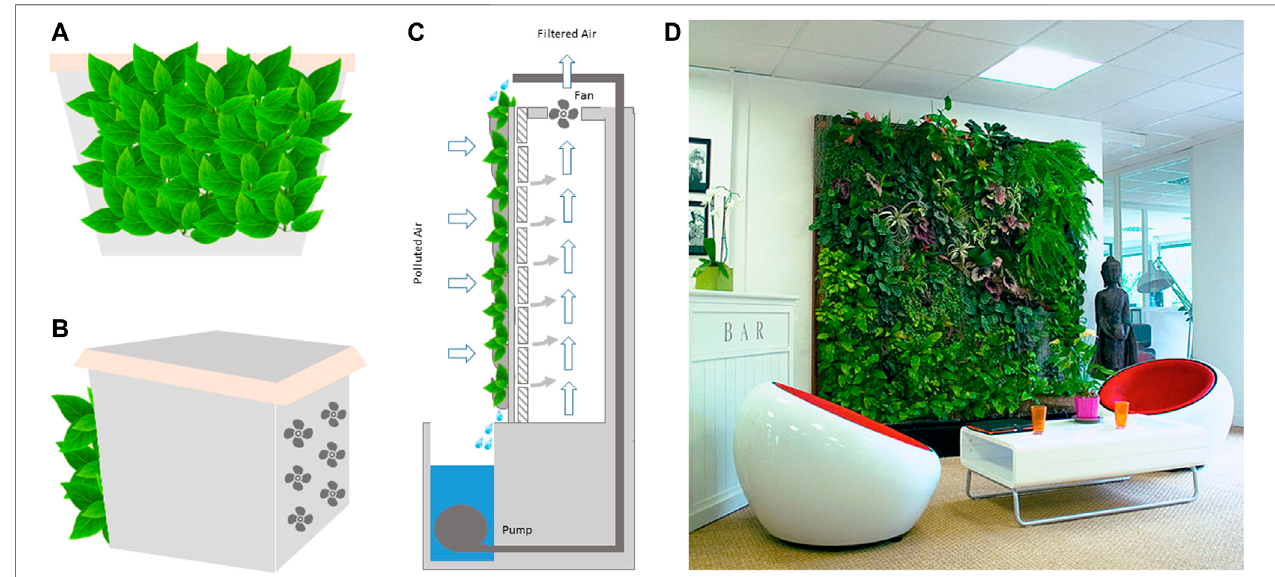
FIGURE1| SchematicofBIABandALWsystems.Section (A,B) representsthefrontandsideviewofBIABsystemwheresection (C) presentsthecross-sectional view of ALW system (D) represents how an indoor living wall system would look like. (Ibrahim et al., 2018; Mannan and Al-Ghamdi, 2020).